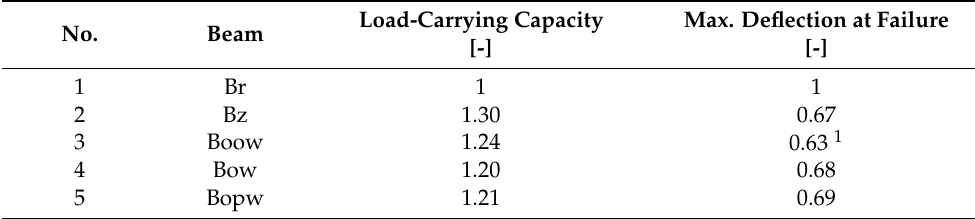
Table 2. Relative values of ultimate load and maximum deflections during failure for laboratory- tested beams.